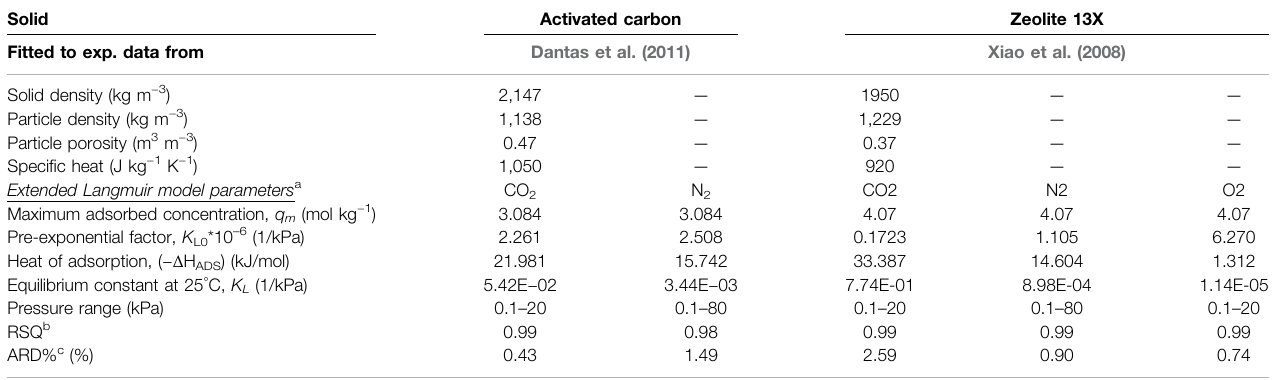
TABLE 1 | Properties of the solids and Extended Langmuir equation parameters. Solid Activated carbon Zeolite 13X Fitted to exp. data from